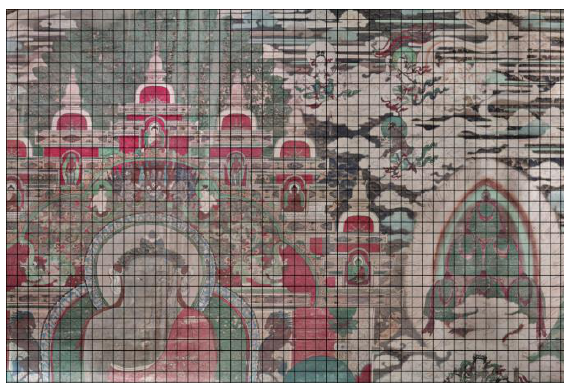
Figure 4. The grid generation on the mural painting of Qutan Temple